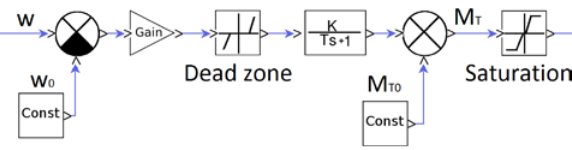
Fig. 2. Block diagram of the turbine speed controller .